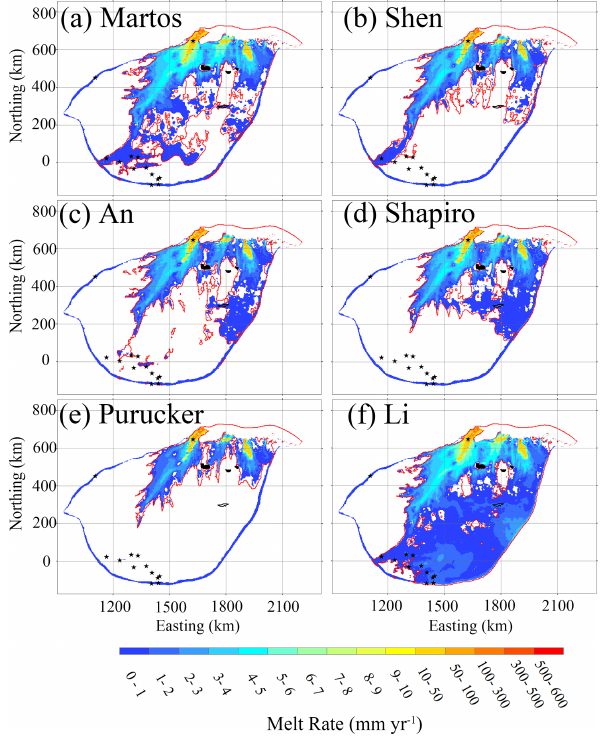
Figure 9. Modelled basal melt rate (mmyr − 1 ) in panels (a) to (f) correspond to the GHF in panels (a) to (f) in Fig. 2. The ice bot- tom at pressure melting point is surrounded by a red contour. The stars denote the locations of observed subglacial lakes, and the area surrounded by the black line is the likely second largest subglacial lake in Antarctica. There is modelled basal refreezing at three local places painted in